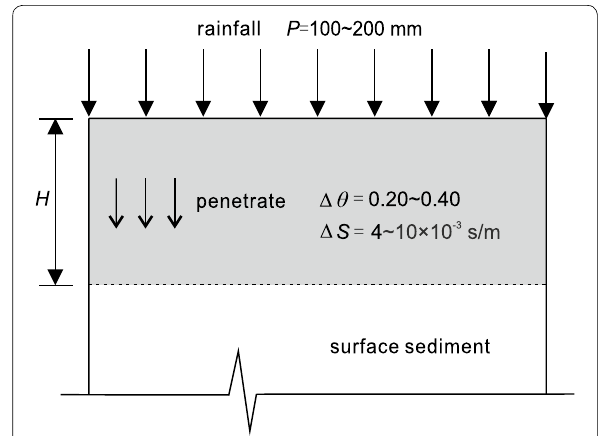
Fig. 6 One‑dimensional model for estimating the travel time increment. From Fig. 5a, for a level VI rainfall with a rainfall total of about 100–200 mm, the variation of volumetric water content ∆ θ and variation of shear wave slowness ∆ S can be estimated as approximately 20–40% and 4–10 10 − 3 s/m, ×